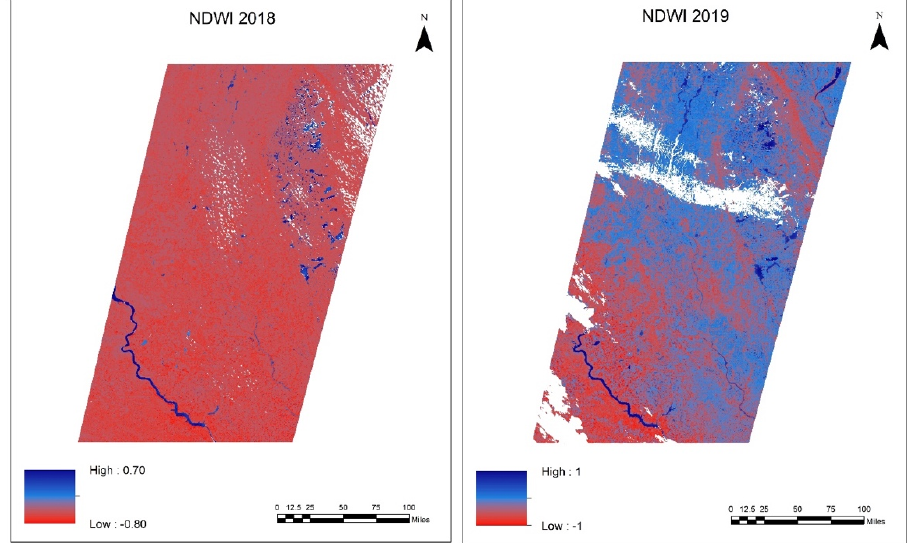
Figure 4. NDWI map of study area for April 2018 ( left ) and June 2019 ( right ) showing general increase in NDWI values across most of the study area.